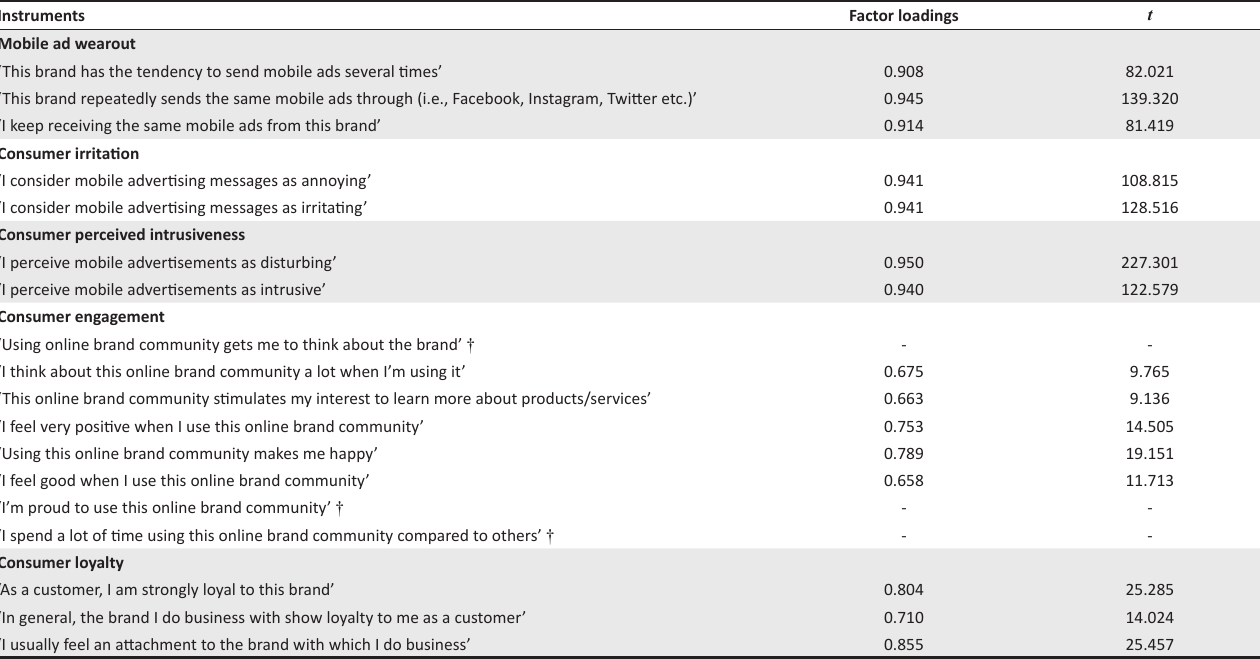
TABLE 1-A1: Research